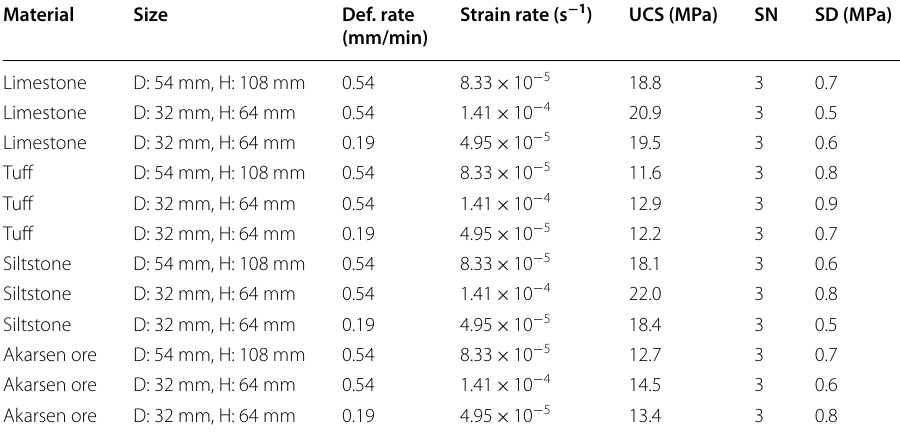
Table 1 Rock strength results obtained from tests with deformation controlled rate (UCS: uniaxial compressive strength, D: diameter, H: height, SN: specimen number, SD: standard deviation)